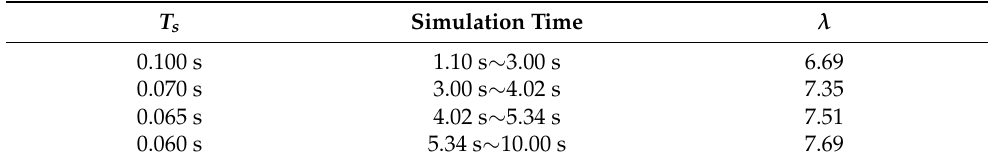
Table 3. Duration of support